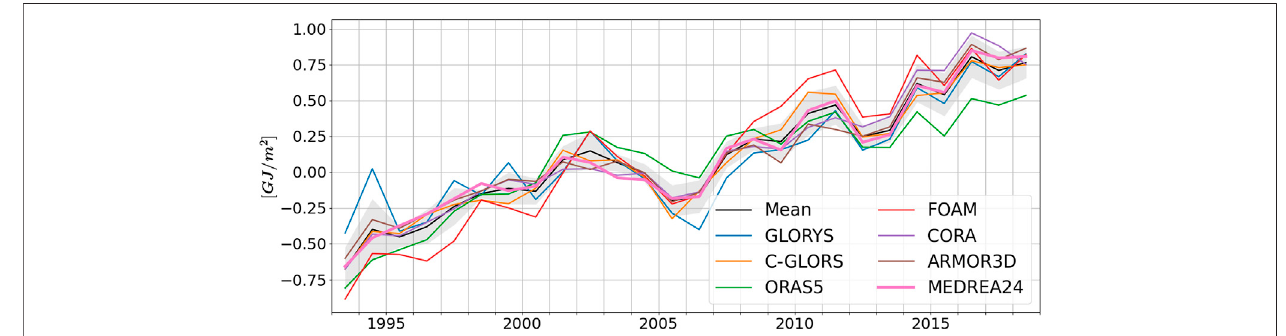
FIGURE 10 | Time series of area averaged ocean heat content anomaly in the Mediterranean Sea, and integrated over the 0 – 700 m depth layer. Time series are based on different data products. The mean pro fi le is in black and the grey shaded area corresponds to the ensemble spread.